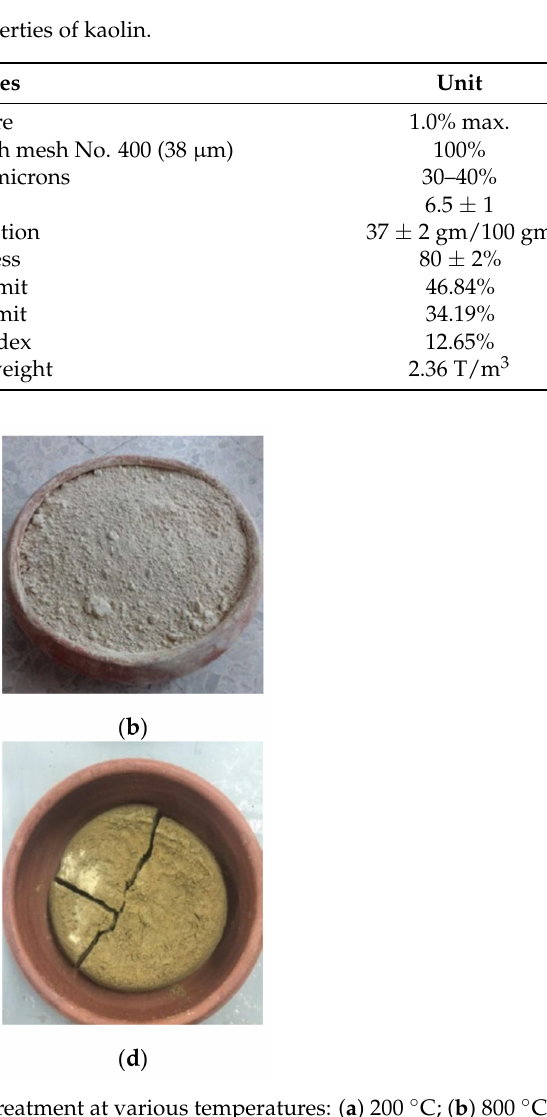
Figure 1. Kaolin after thermal treatment at various temperatures: ( a ) 200 ◦ C; ( b ) 800 ◦ C; ( c ) 1000 ◦ C; ( d ) 1200 ◦